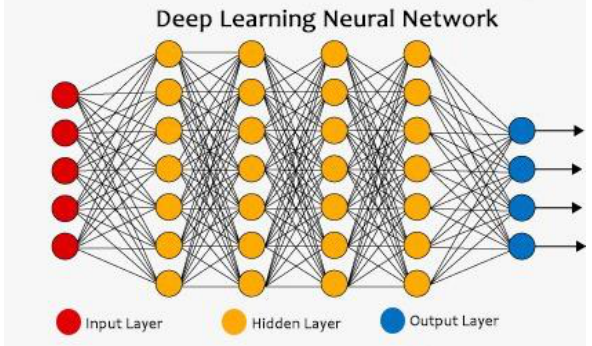
Figure 1.1 The structure of Deep